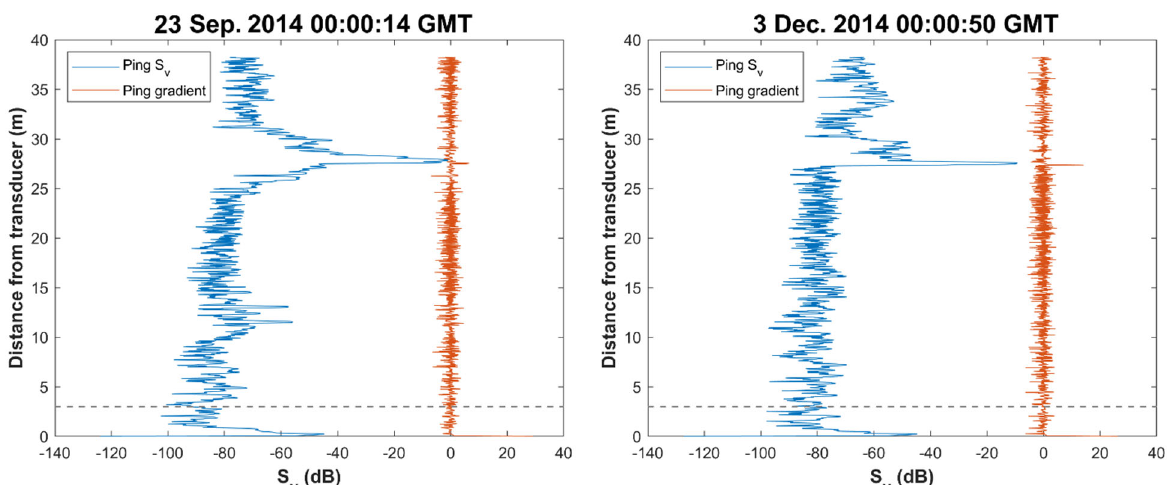
Figure 3. Representative acoustic return ping profiles from the AZFP dataset in open water ( left ) and ice cover ( right ). Each plot shows the acoustic backscatter amplitude scattering volume S v of a single ping plotted over uncorrected distance from the AZFP transducer (blue), and the S v gradient (red). The gray dashed line represents the 3 ‐ m nearfield echo exclusion zone.